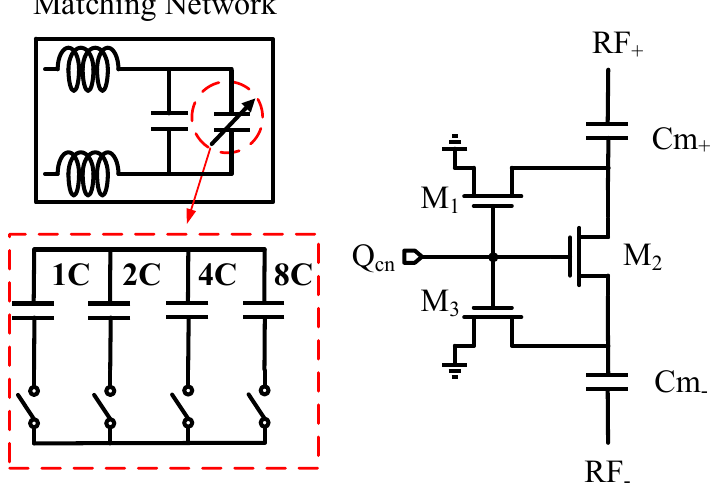
Figure 5. Capacitor array of AIM network.